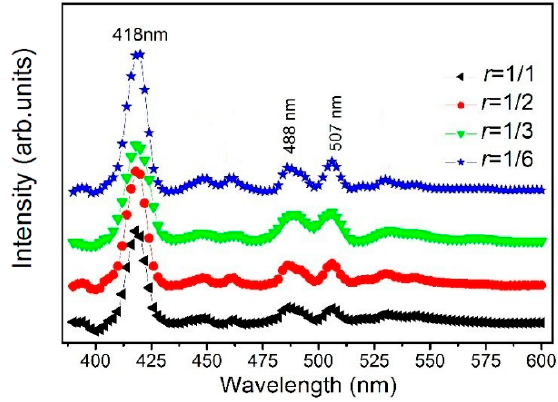
Figure 6. Photoluminescence spectra of Cu 3 N films prepared at different values of r.